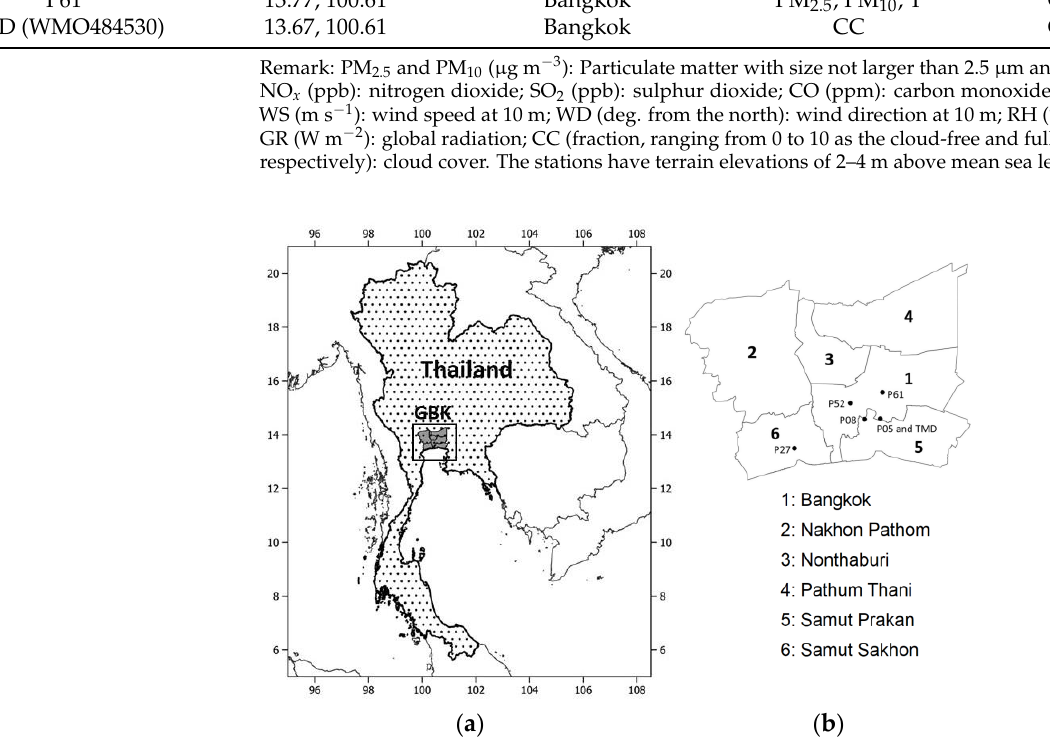
Figure 1. ( a ) Thailand and Greater Bangkok (GBK); ( b ) GBK provinces with PCD and TMD stations.